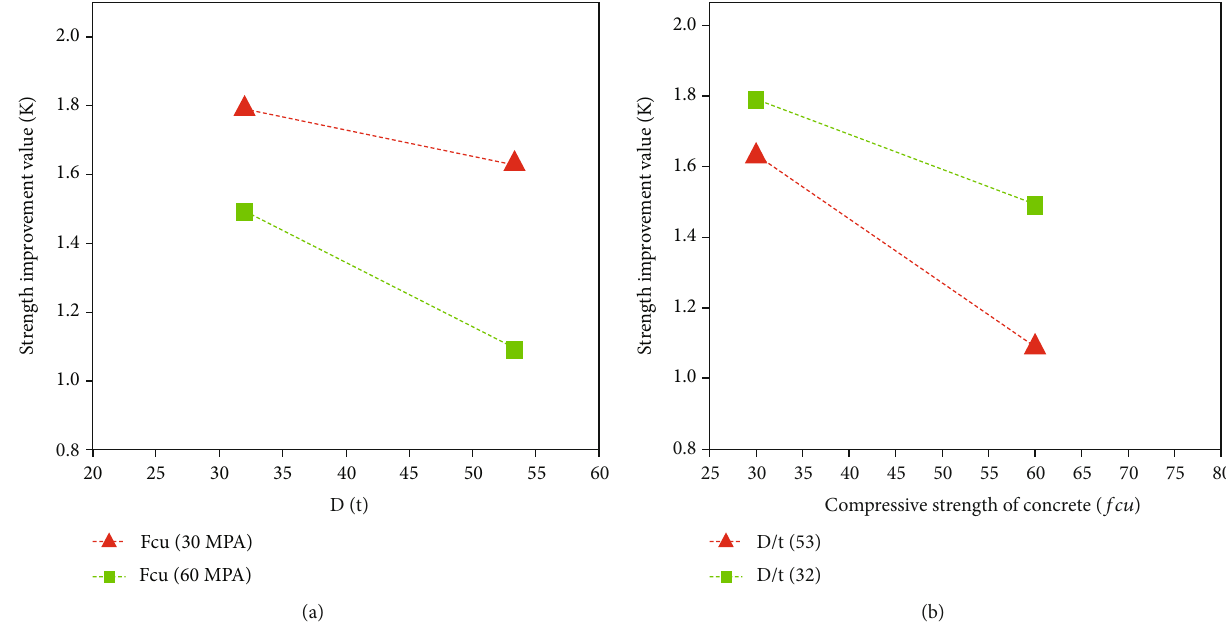
Figure 7: Concrete strength improvement value.